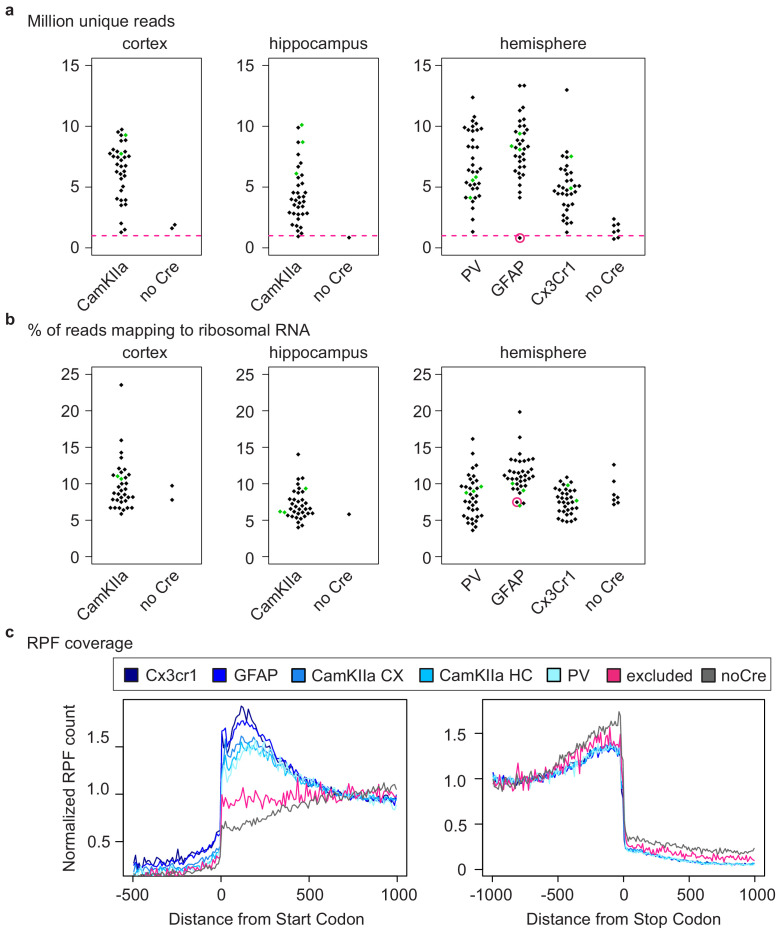
Analysis of different CNS cells via cell-type-specific ribosome profiling.(a) Beeswarm plots displaying million unique reads. Samples are grouped according to analyzed regions and Cre driver. Only Cre+ samples with at least one million unique reads (indicated by a dashed pink line) were analyzed. One Cre+ samples did not pass quality control and was therefore excluded (encircled in pink). Terminal PrD samples are colored in green. (b) Beeswarm plots displaying the % of reads mapping to ribosomal RNA (rRNA). Samples are grouped according to analyzed regions and Cre drivers. One Cre+ samples did not pass quality control (>one million unique reads and >70% of reads mapping to the coding sequence) and was therefore excluded (encircled in pink). Terminal PrD samples are colored in green. (c) Density plots displaying the ribosome protected fragments (RPF) coverage relative to the translational start (left) and stop (right). RPF counts were normalized for transcript abundance and the number of transcripts represented at each position. Shown are representative samples of the different cell types and a Cre-negative sample as well the excluded Cre+ sample.